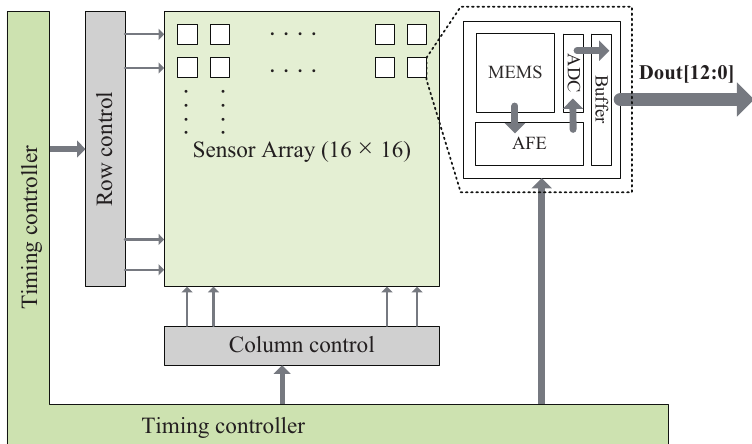
Figure 1. System block diagram of the proposed CMOS tactile sensor readout